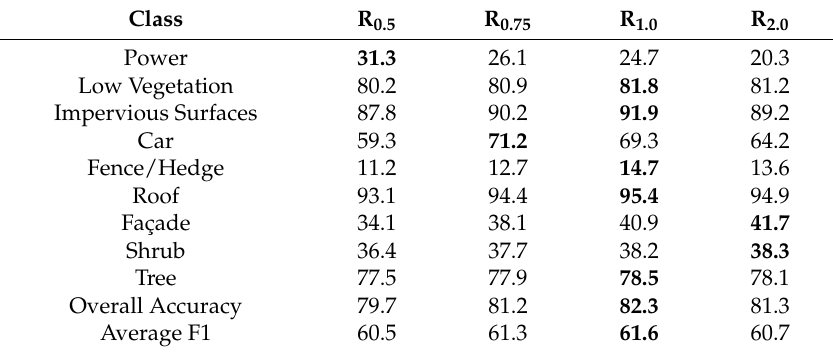
Table 2. The recall value, the overall accuracy of each class and average F1 value for different neighborhood radii in (%). Bold numbers show the highest values within the different radii. Class R 0.5 R 0.75 R 1.0 R 2.0 Power 31.3